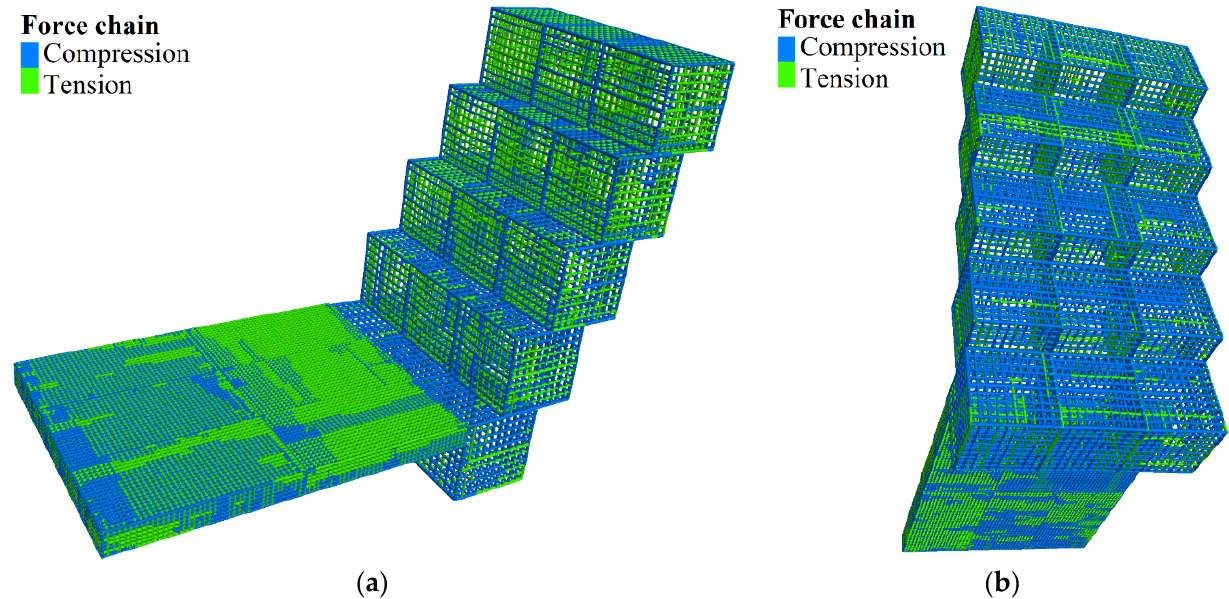
Figure 17. Stress state of the BFR cages. ( a ) Positive side. ( b ) Backside.